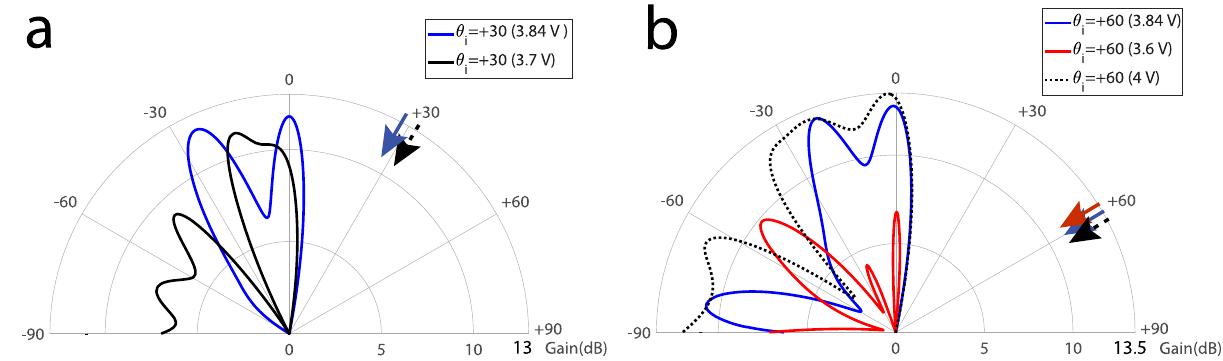
Fig. 9 Experimental results for the controllable beamsteering mechanism. a θ i = 30° at 5.81 GHz. b θ i = 60° at 5.81 GHz.